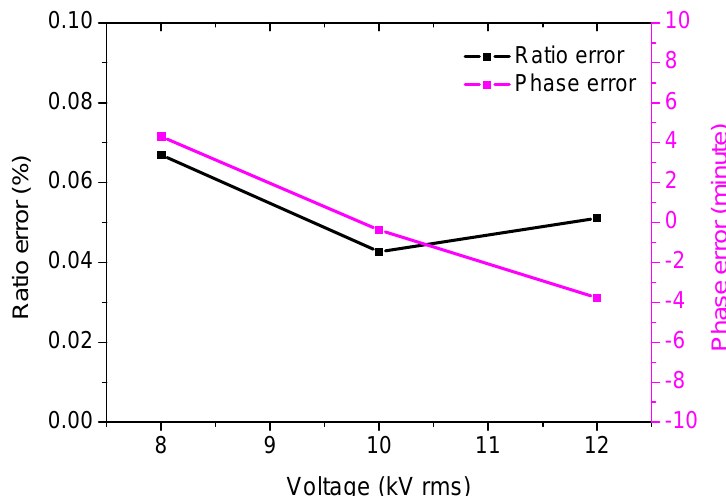
Figure 6. Ratio error and phase error versus applied voltage from 8 kV to 12 kV